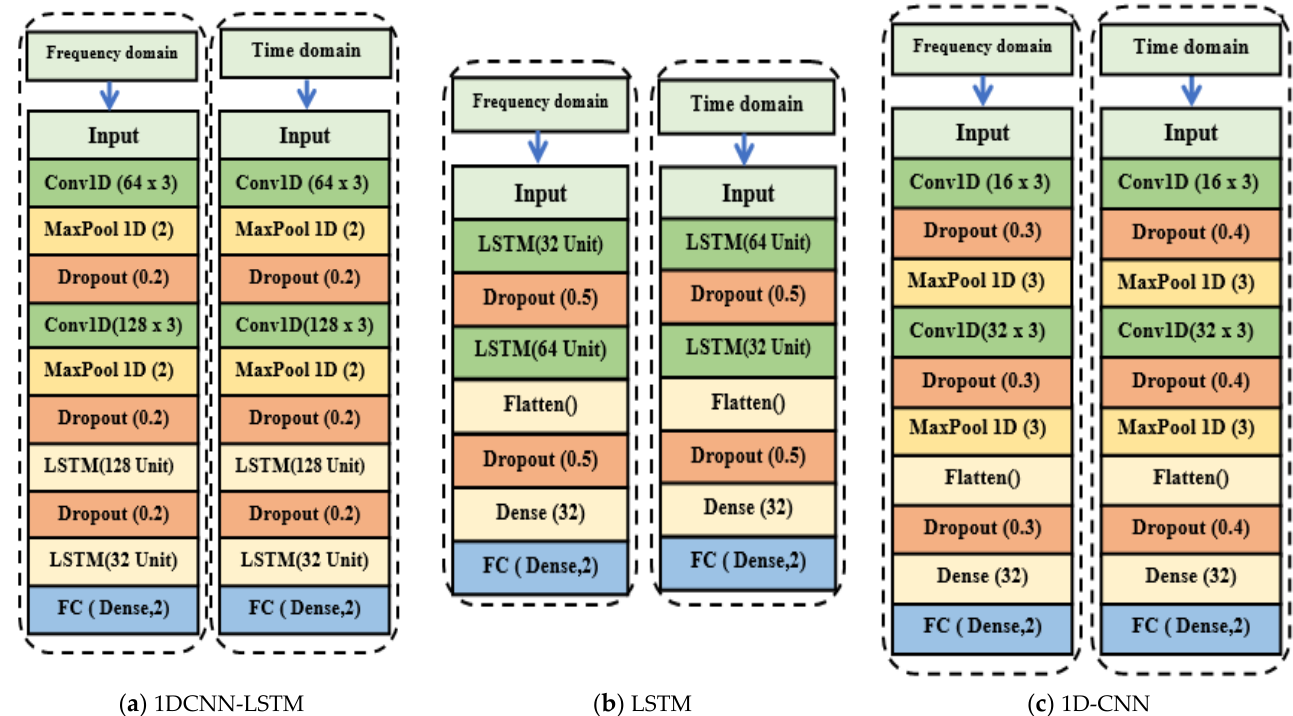
Figure 5. The suggested ( a – c ) model’s architecture (in case Time and Frequency domain). Table 2. The deep learning algorithm designs for time